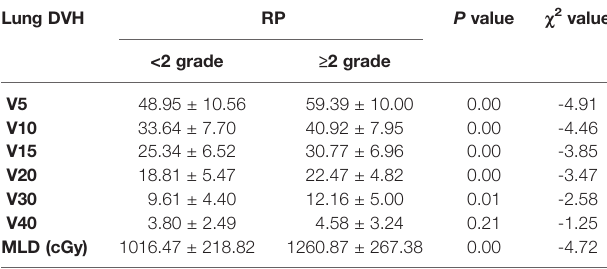
TABLE 2 | Single factor analysis of DVH and RP.